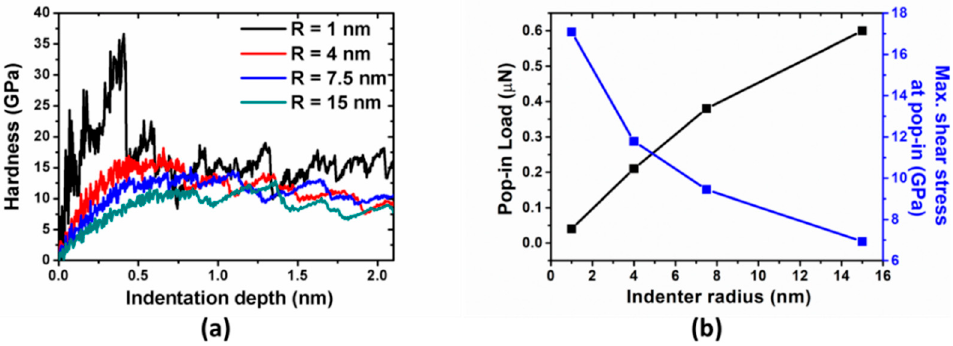
Figure 3. ( a ) Hardness vs. indentation depth with different tip radii; ( b ) pop-in loads (black), and corresponding maximum shear stresses (blue) as a function of indenter radius.